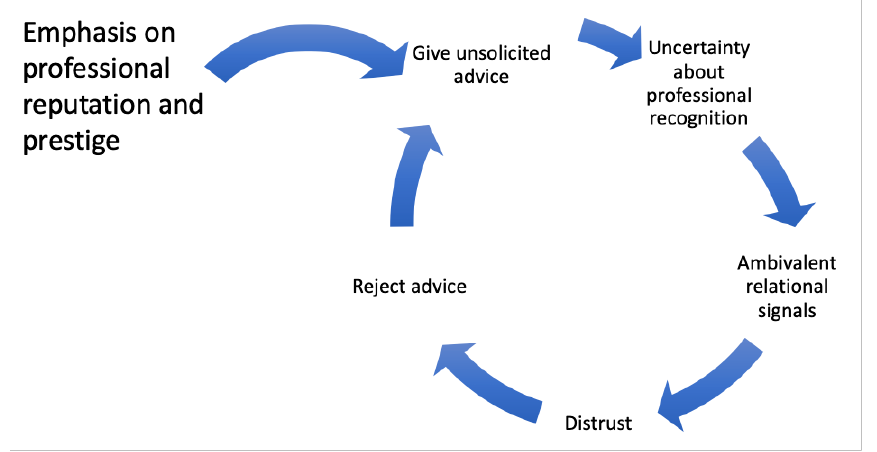
Figure 1: Example for a Reputation